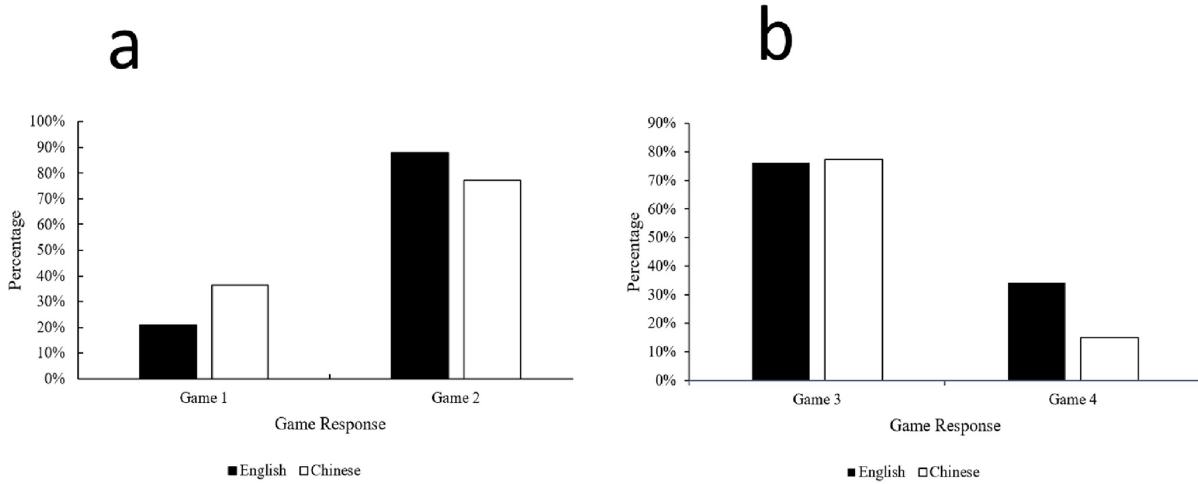
Fig 1. The percentages (%) of cooperation for the four games in each language group. a: Percentage of cooperation in Prisoner’s Dilemmas; b: Percentage of cooperation in Volunteer’s Dilemmas.